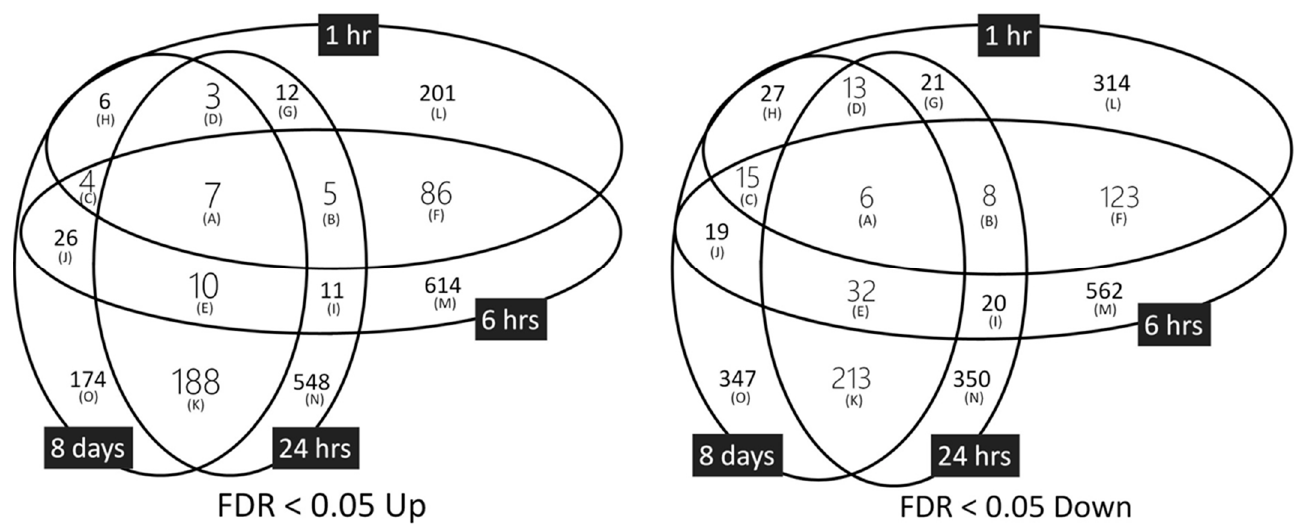
Figure 2. Genes showing up (Up)-or down (Down)-regulation in response to TPA treatment. FDR, false-discovery rate.